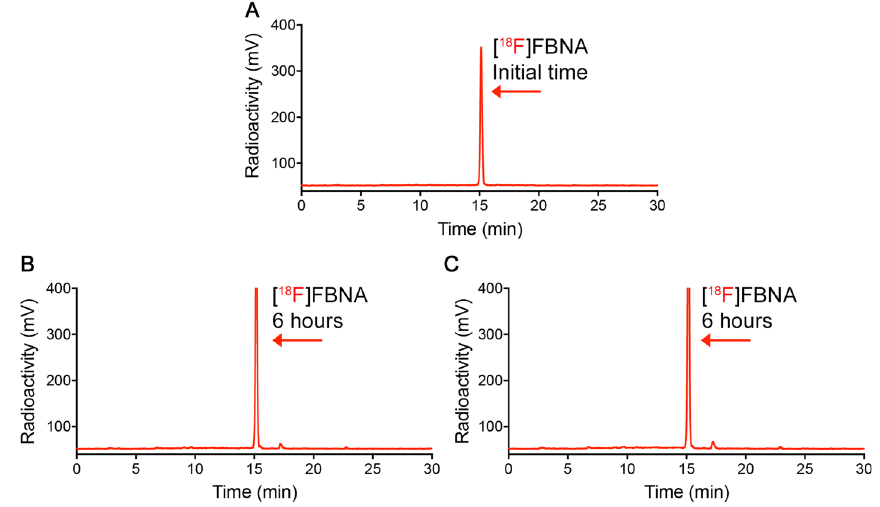
Fig. 5 Radio-HPLC traces obtained after the incubation of [ 18 F]FBNA (t R : 15.2 min) at ( A ) the initial time (t 0 min), ( B ) physiological saline solution (NaCl 0.9%) after 6 h or ( C ) mouse serum after 6 =